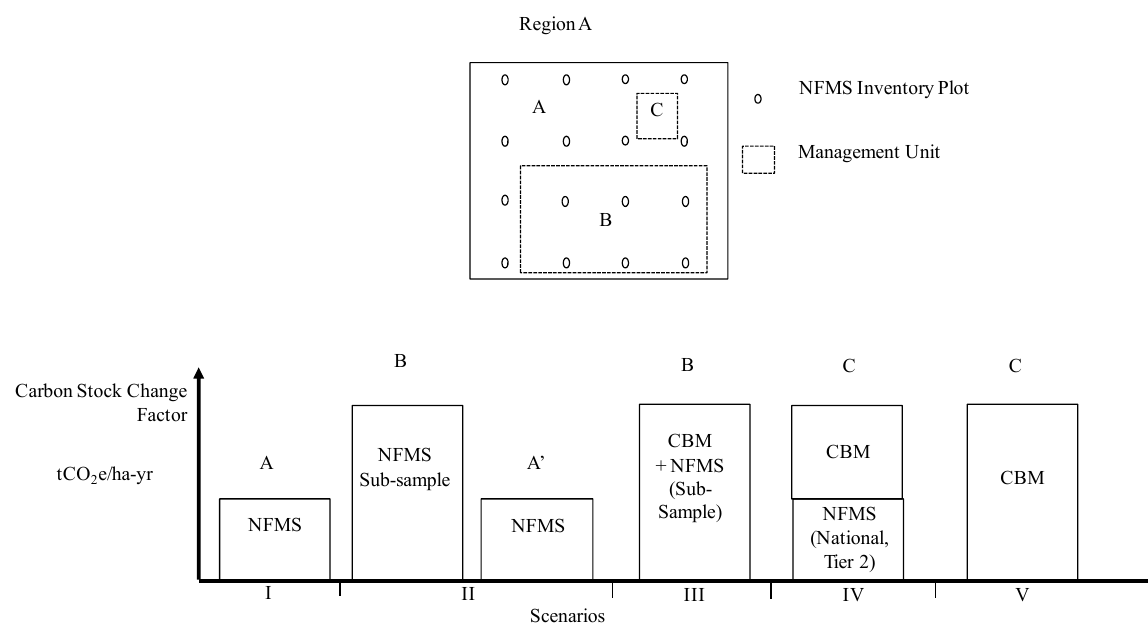
Figure 2. Options to integrate local data produced through CBM with NFMS in